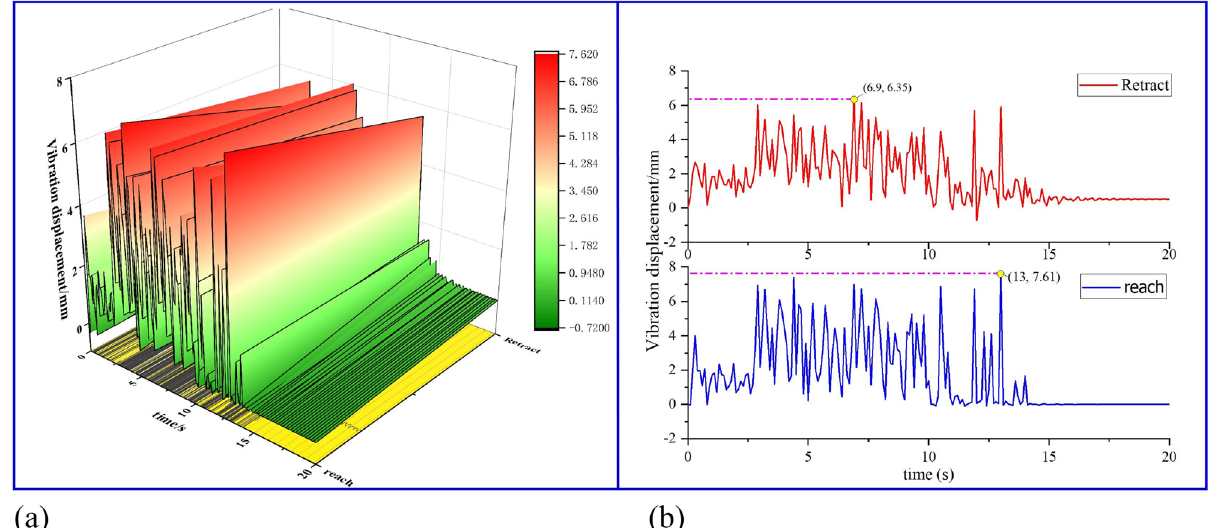
Figure 11. Vibration displacement diagram of drill pipe under cantilever extension or retraction operation: ( a ) vibration displacement surface diagram of drill pipe during cantilever extension/retraction operation; ( b ) projection of vibration displacement of drill pipe during cantilever extension/retraction operation.